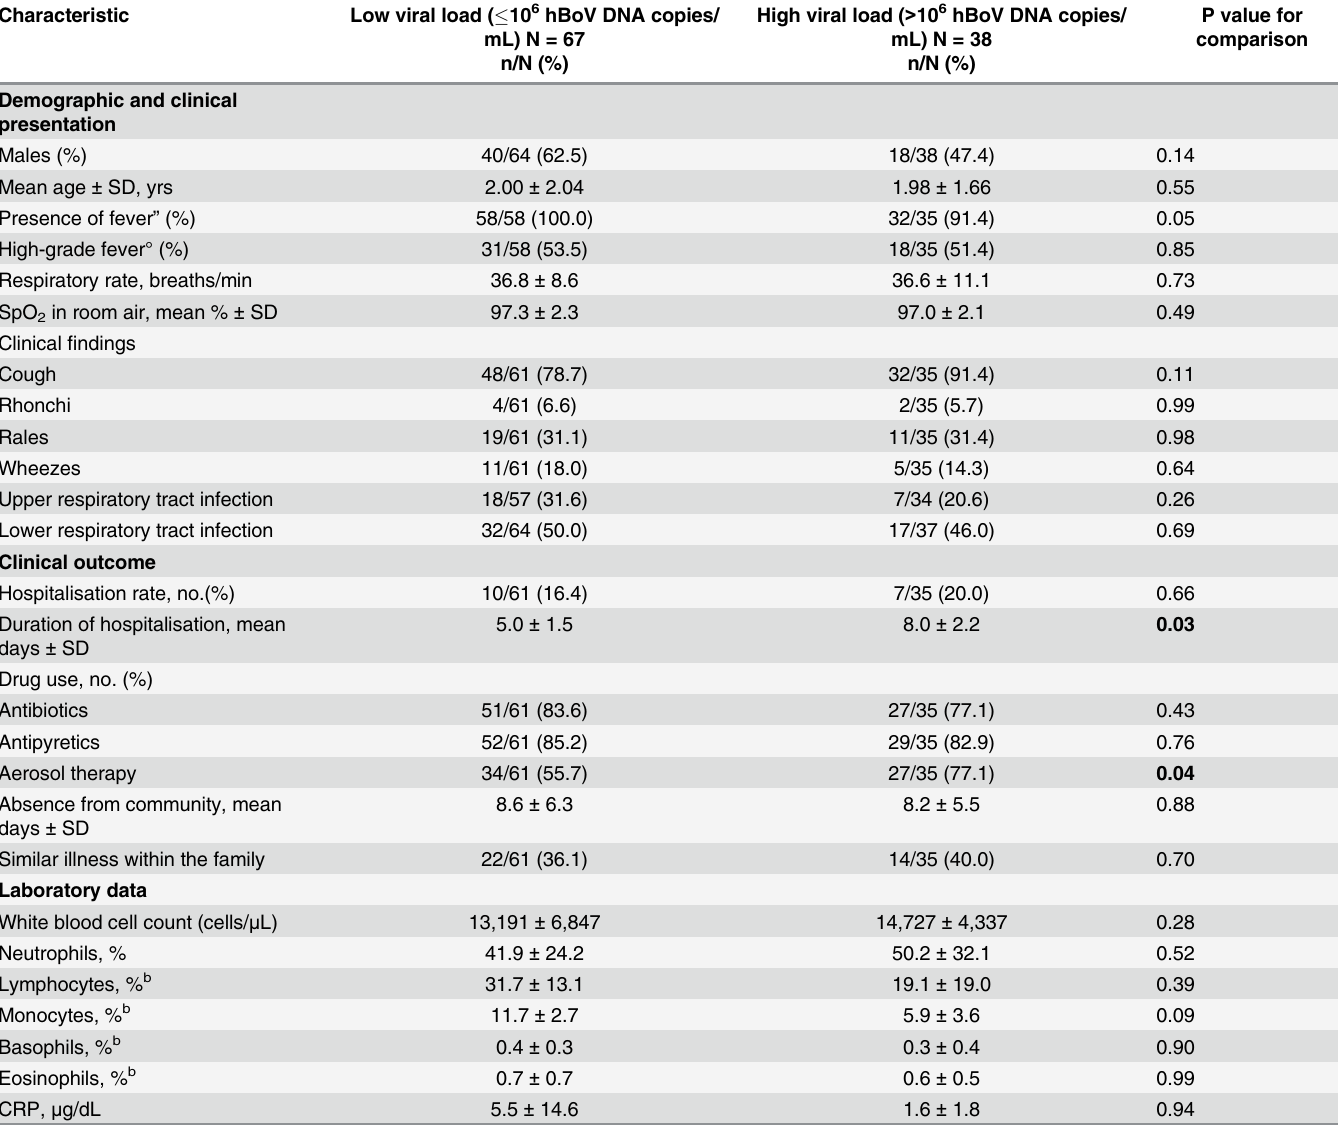
Table 5. Comparison between subjects with low and high viral human bocavirus loads, according to demographic, clinical and laboratory variables. a Characteristic Low viral load ( (cid:3) 10 6 hBoV DNA copies/ mL) N =